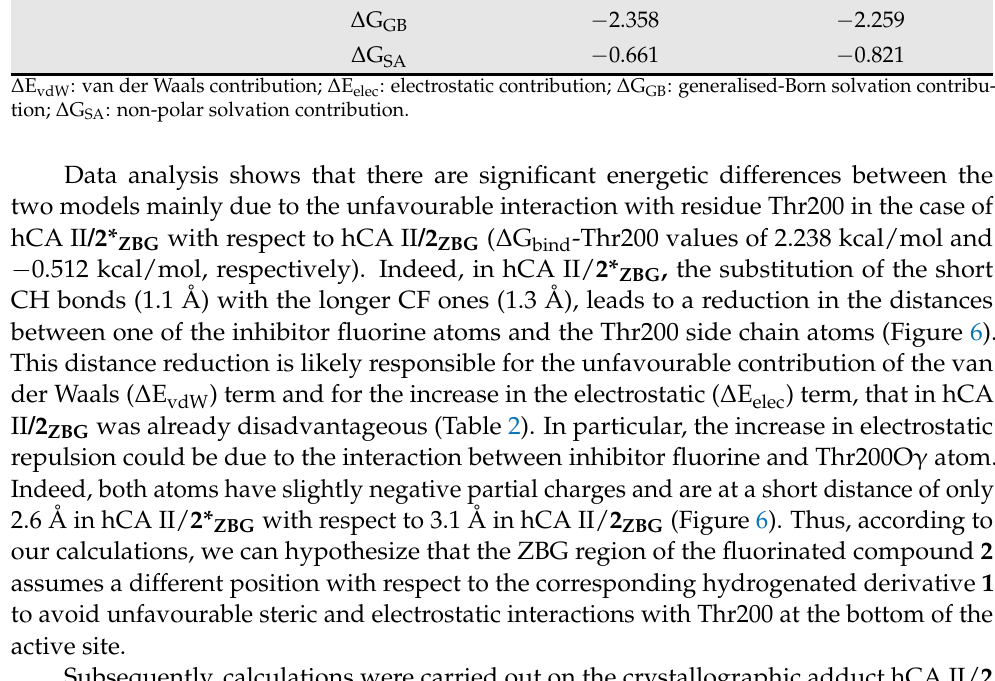
hCA II/2 ZBG hCA II/2* ZBG − 1.234 − 0.988 − 0.968 − 1.130 − 5.170 − 5.644 − 1.890 −